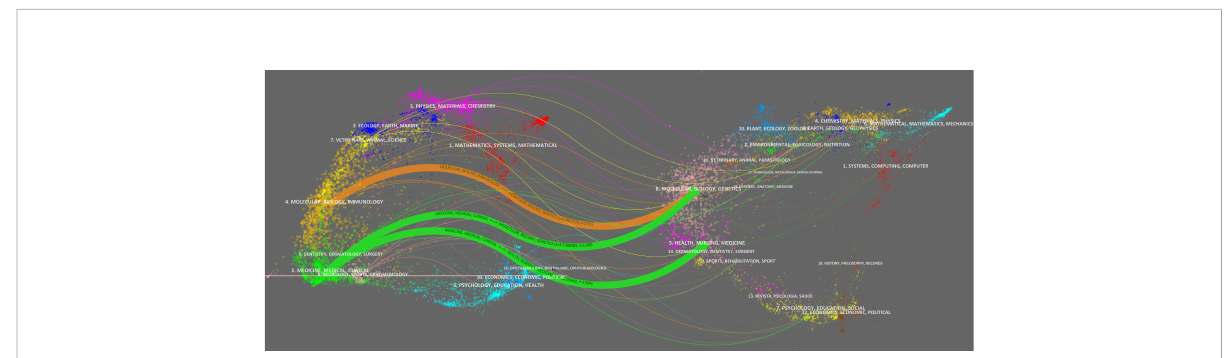
FIGURE 8 The dual-map overlay of journals on RNA methylation in DM and its complications. The left nodes represent the included literature; the right represent the references in the literature. The labels represent the discipline. The link represents the cited path.